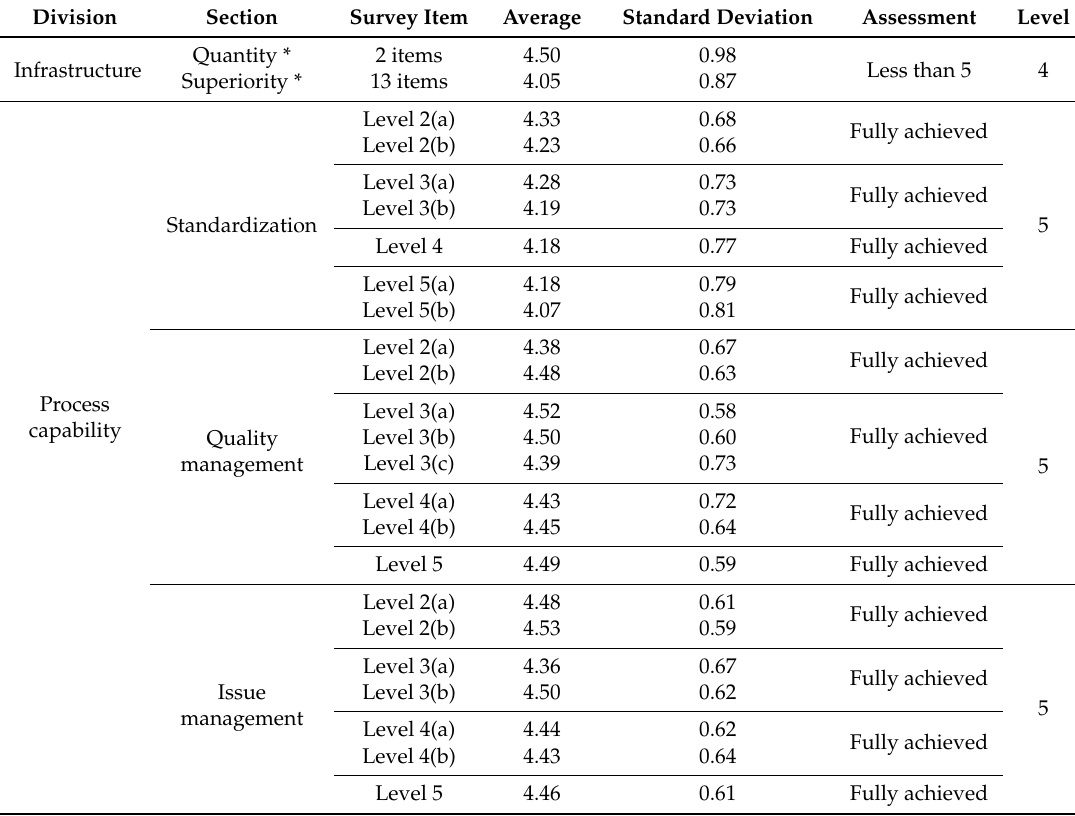
Table A2. Survey results to assess organizational competitiveness—Department B.